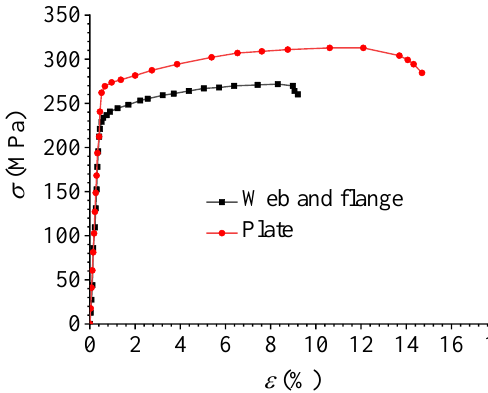
Figure 3. Stress–strain curve of aluminum alloy.